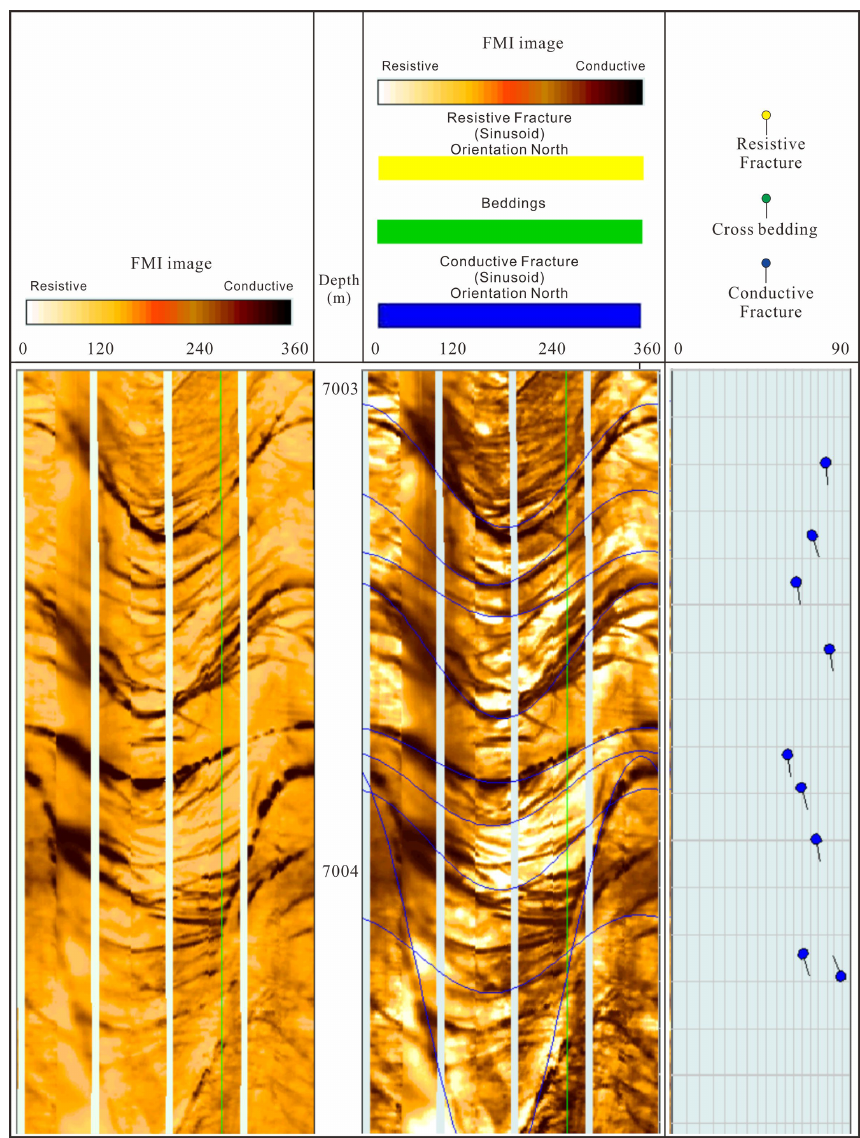
Figure 12. Image logs showing the dissolution along fracture surfaces, forming vuggy fracture of Bashijiqike Formation in Kuqa